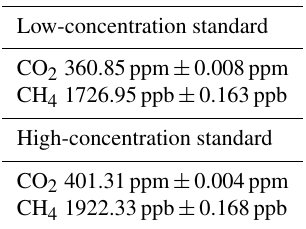
Table 2. Values of the calibrated gas standards using NOAA’s WMO scale reference. The air of the two reference tanks used in this study was measured at LSCE with a Picarro G2401 calibrated with a scale of six tanks from NOAA/ESRL. The table shows the re- producibility of the measurements and standard deviation over three measurements made during a 15-day period.